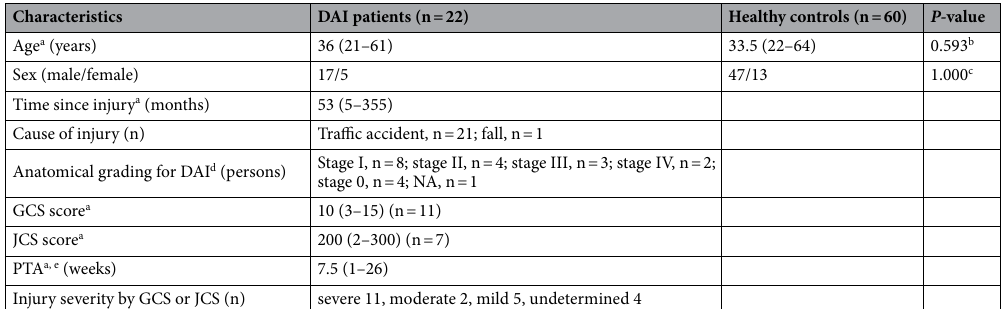
Table 5. Demographic and clinical characteristics of the participants in Experiment 2. a Median (range). b Groups were compared with the Mann–Whitney U test. c Groups were compared with the chi-square test. d Anatomical grading for DAI: stage I, hemispheric lesions; stage II, hemispheric and additional corpus callosum lesions; stage III, brainstem lesions; stage IV, lesions in the substantia nigra or mesencephalic tegmentum; stage 0, absence of hemorrhagic spots in chronic-phase images but evidence of microbleeds on acute-phase X-ray computed tomography images. e “PTA (weeks) = X” indicates “7X–6 ≤ PTA (days) ≤ 7X”. For example, “PTA (weeks) = 2” indicates “PTA (days) = 8–14”. DAI Diffuse axonal injury, GCS Glasgow coma scale, JCS Japan coma scale, PTA Duration of posttraumatic amnesia, NA Not available.